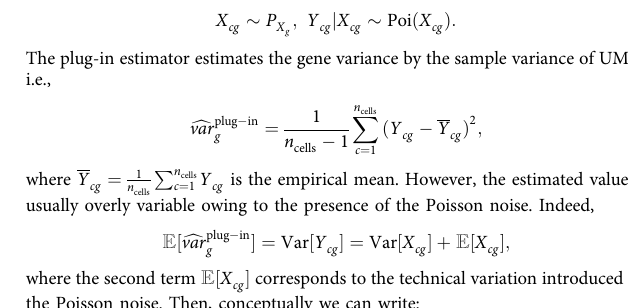
Fig. 5 Validation using smFISH data. a The estimated CV (top) and inactive probability (bottom, κ ¼ 2 : 5 n the smFISH results. The EB estimates (right) are consistent with the smFISH results while there is a clear in fl ation for the plug-in estimates. b The sequencing budget tradeoff for estimating CV (top) and inactive probability (bottom, κ ¼ 1, i.e., estimating the zero proportion at 1 read per cell) for the gene MITF . The relative error is evaluated against the gold standard smFISH result. 3-std con fi dence intervals are experiment can be used to provide such an estimate. Also, data from past studies or public databases, either scRNA-seq or bulk RNA-Seq, can be used to provide the estimate. Some popular databases include Tabula Muris (scRNA-seq) 39 for different mouse tissues, Human Cell Atlas 29 (scRNA-seq) and GTEx 40 (bulk RNA- Seq) for different human tissues, TCGA 41 (bulk RNA-Seq) for human cancer data, and GEO 42 (bulk/single-cell RNA-seq) for past studies. One caveat here is that different datasets may have different covariate compositions, like sex, age, or demographic factors. To evaluate the sensitivity of using reference data to estimate p (cid:5) for the proposed experimental design procedure, we consider four different types of reference data in Supplementary Figs. 18 – 19: in-sample bulk RNA-Seq or scRNA-seq, where the corresponding reference data were obtained from the same biological sample as the data for the current study, and their out-of-sample